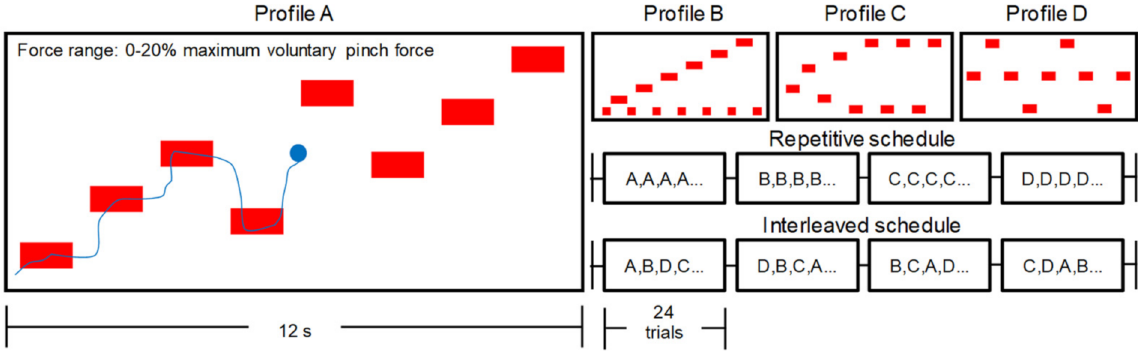
Figure 2. Depiction of visuomotor tracking task (VTT). Profiles A–D represent the four different target profiles that were used in the